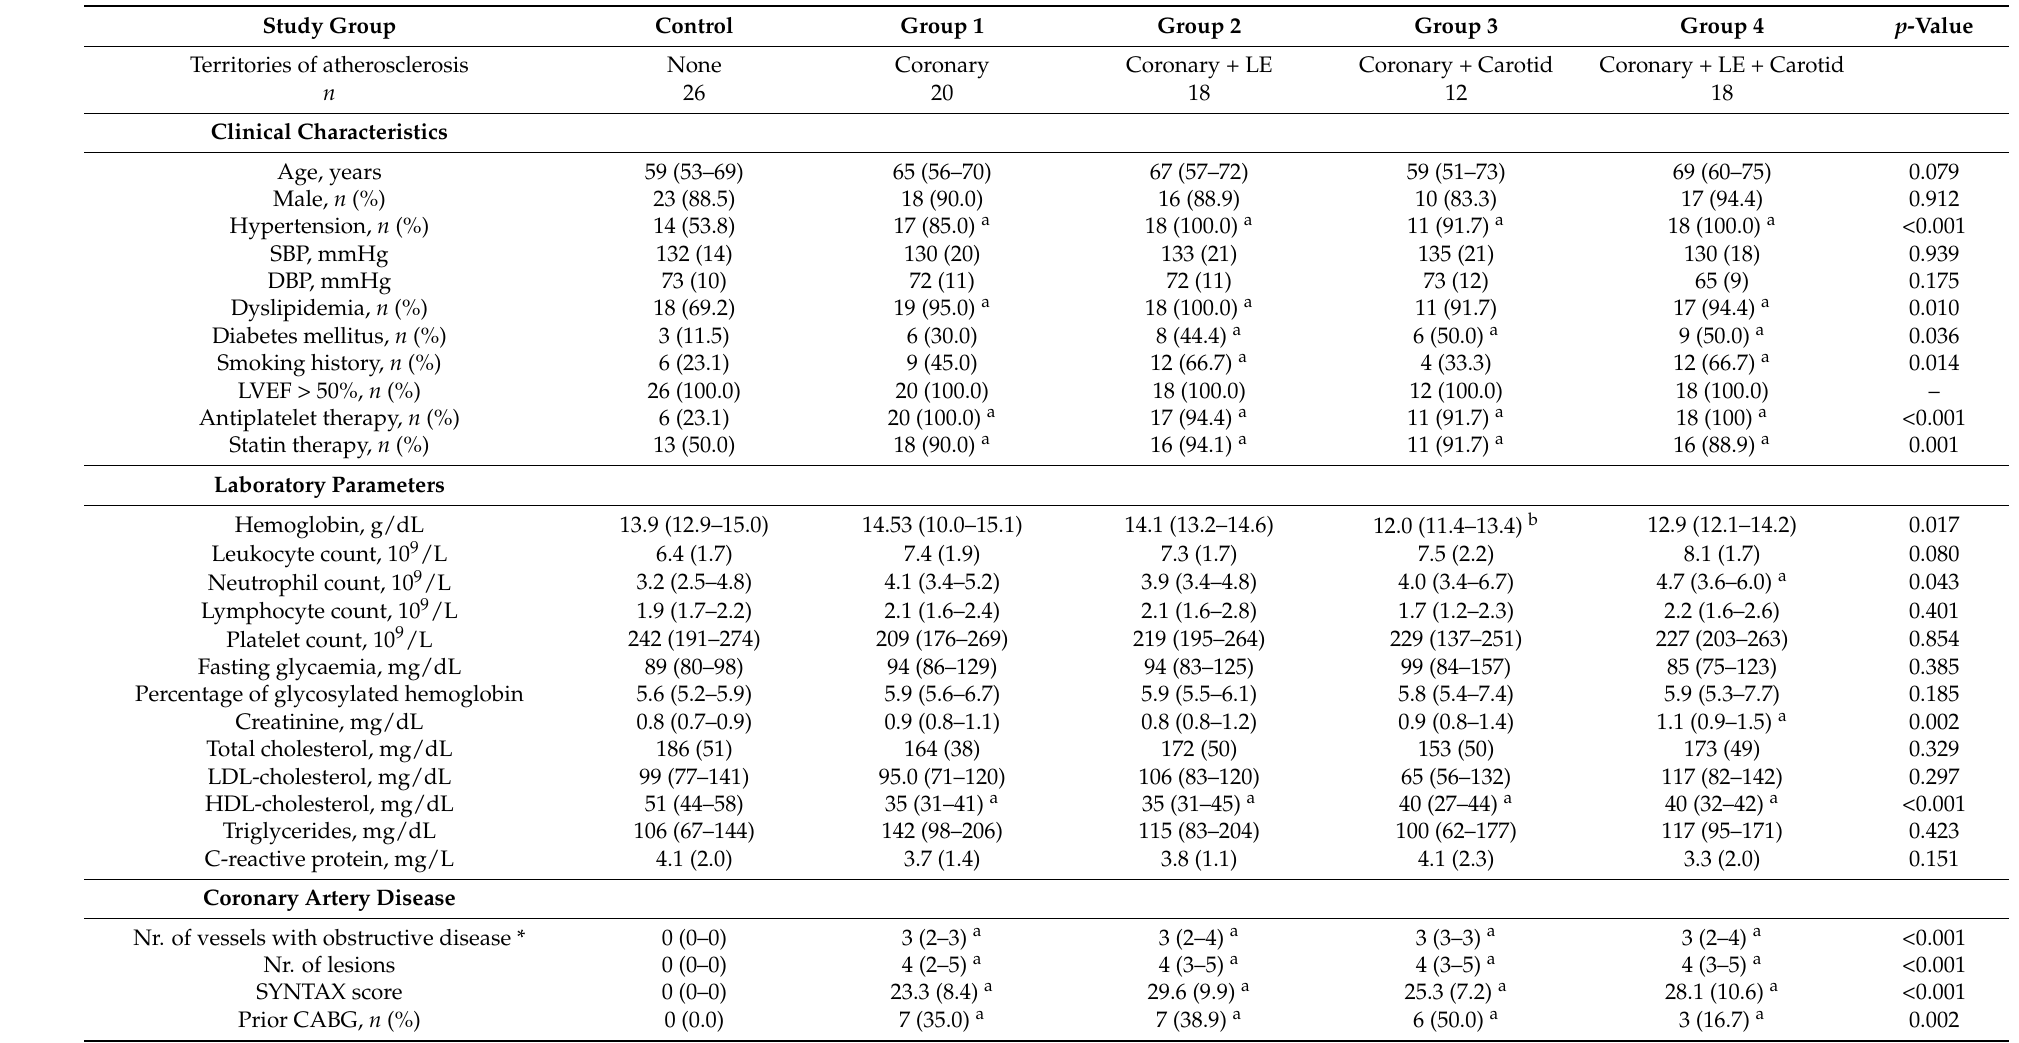
Table 1. Characteristics of the participants according to the involved territories of